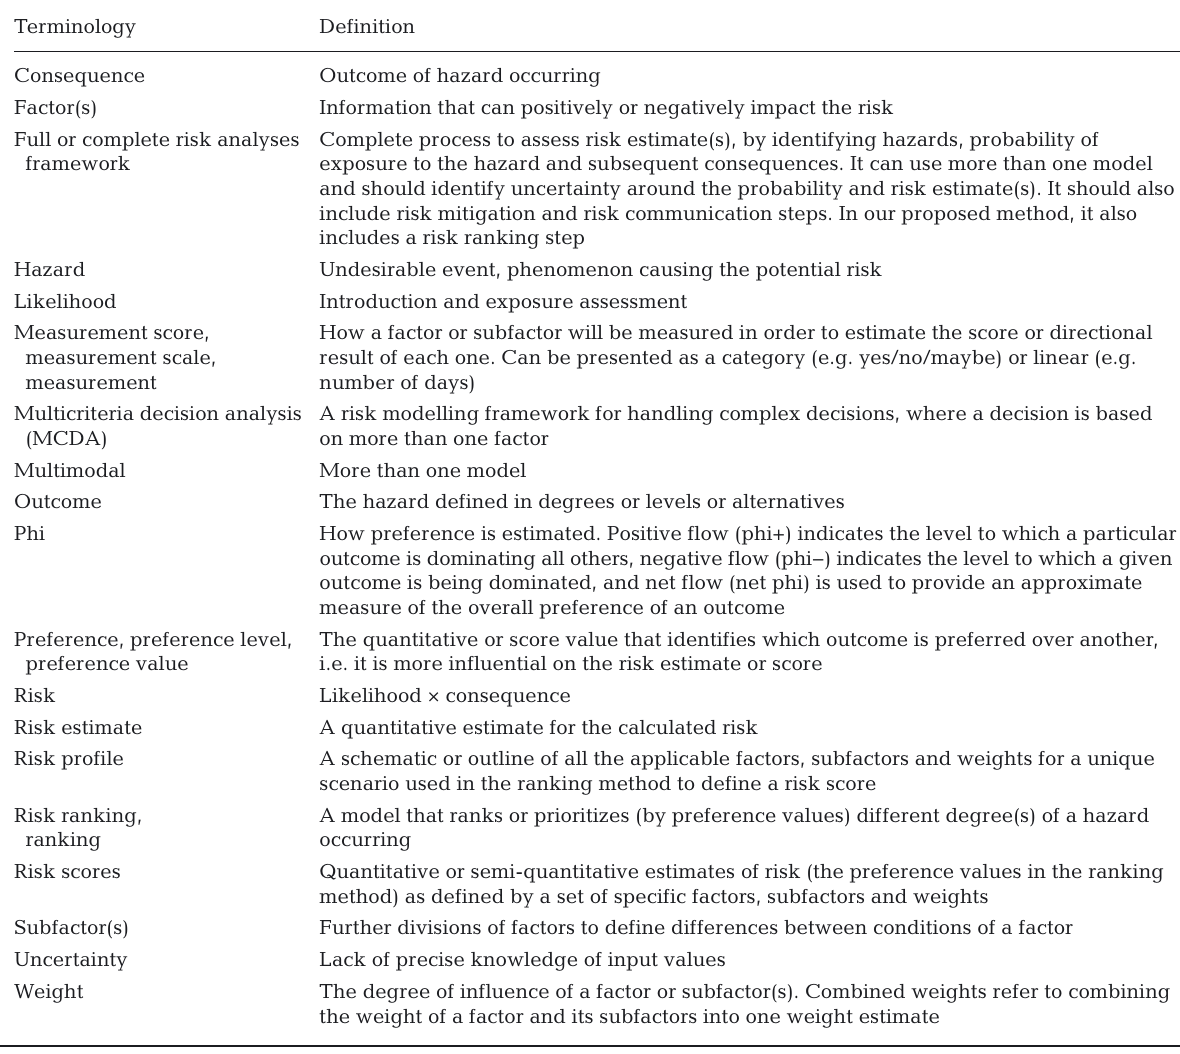
Table 1. Definition of risk analyses terminology